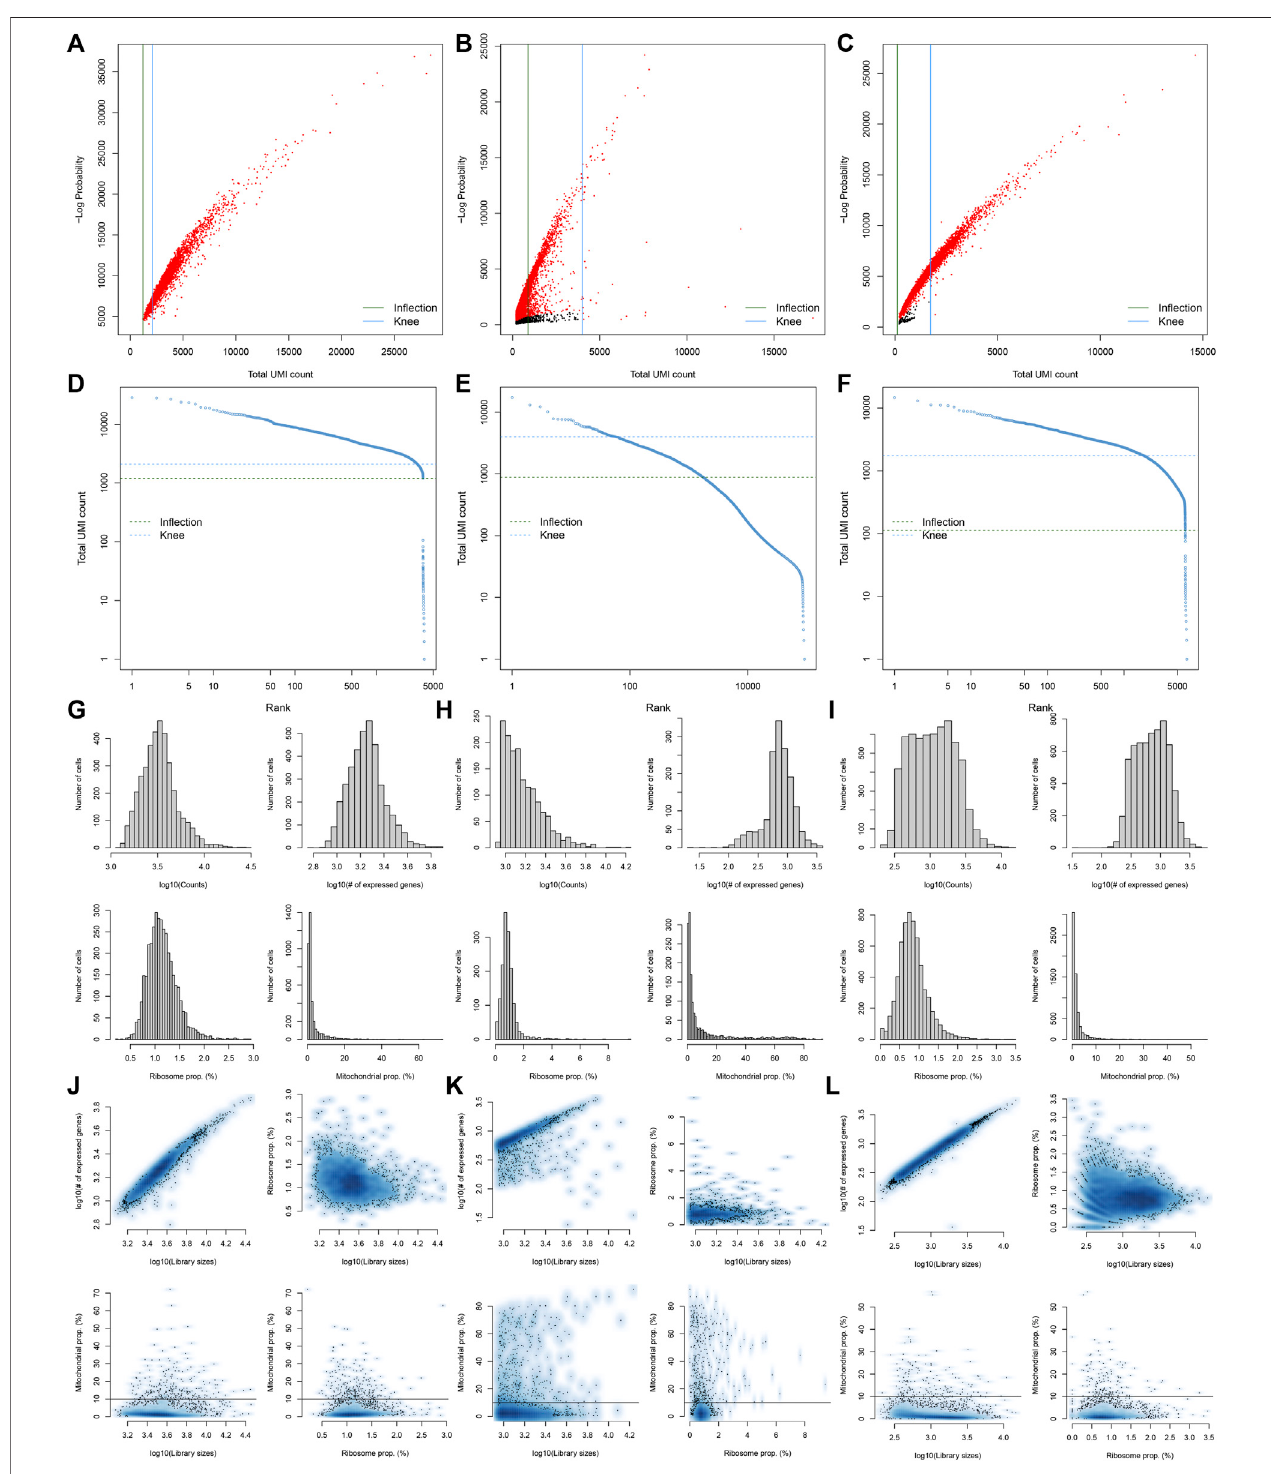
FIGURE1 | Pre-processing, quality control, and normalization of scRNA-seq data of the control kidney specimens. (A – C) The total count against the negative log-probability in three healthy kidney specimens. Red indicated cell droplet and black indicated empty droplet. (D – F) Barcode rank plots in three healthy kidney specimens.Thein fl ectionpointsofthekneeindicatethetransitionofthetotalcountdistribution. (G – L) Theratiosofmitochondrialandribosomalgenesexpressedin each cell of the three healthy kidney specimens.